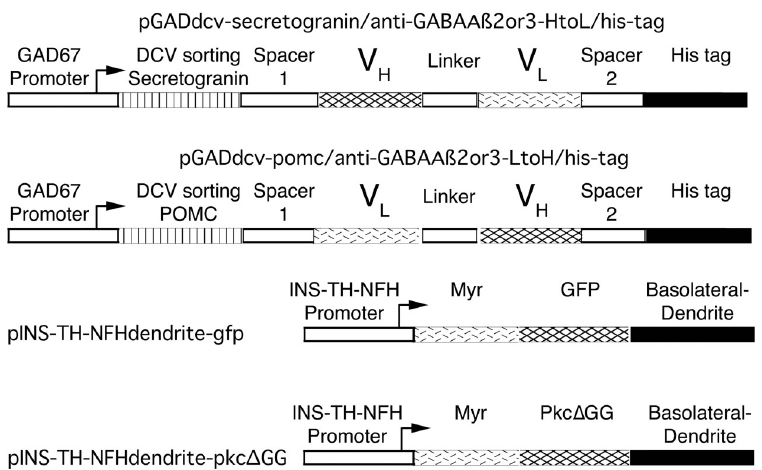
Fig 2. The transcription units in the pre- or post-synaptic vectors. These four vectors all contain a standard HSV-1 vector backbone [21]. The two presynaptic vectors use the GABAergic-specific GAD67 promoter to express a synthetic peptide neurotransmitter designed to bind to GABA A ß2 or ß3 subunits. Each synthetic peptide neurotransmitter contains a DCV sorting domain, either from Secretogranin II or POMC, a spacer (spacer 1, 42 bp), a ScFv anti-GABA A ß2 or ß3, another spacer (spacer 2, 60 bp), and the His tag. The ScFv contain either the heavy or light chain variable region, a established linker, (Gly 4 Ser) 3 [25], and the other variable region. The two spacers separate the ScFv from the other domains, and are designed to enable each domain to function without steric hindrance from the other domains. The two postsynaptic vectors have been reported [21], and express a dendrite-targeted marker, either GFP or Pkc Δ GG (an enzymatically inactive PKC) from the pan-neuronal INS-TH-NFH promoter. Two dendrite-targeting signals are fused to each marker; first, a myristoylation/palmitoylation (Myr) site (from Fyn) , and, second, a basolateral/ dendrite membrane-sorting domain (from the low density lipoprotein receptor)